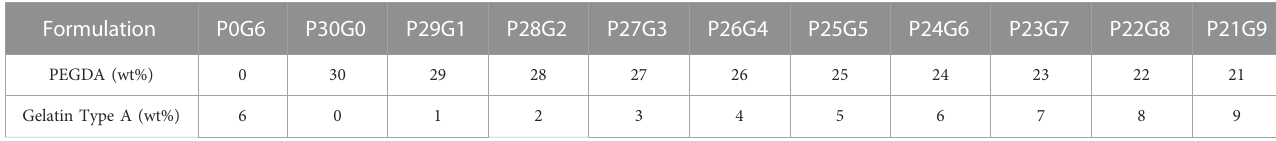
TABLE 1 Precursor